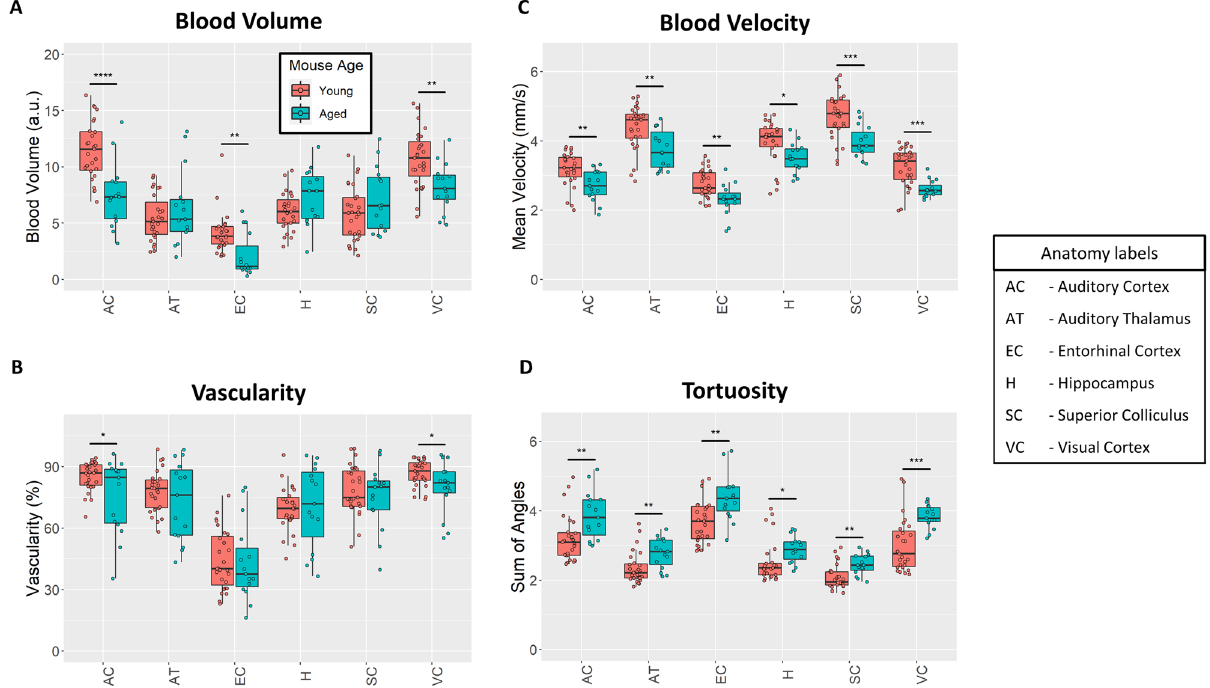
Figure 5. Quantitative ULM measurements. ( A ) Cortical blood volume was significantly decreased in the aged mouse group in comparison to the young group ( p < 0.001 for the auditory cortex, p = 0.007 for entorhinal cortex, and p = 0.001 for visual cortex). ( B ) Likewise, ULM measured vascularity demonstrated a significant decrease in the auditory cortex and visual cortex of the brain between the aged and young group ( p = 0.018 and p = 0.02, respectively). ( C ) Blood velocity exhibited global decreases across all measured brain regions in the aged mouse cohort. The superior colliculus ( p < 0.001) and visual cortex ( p < 0.001) demonstrated the most substantial decrease in mean velocity, with proportionally less decrease in the hippocampus ( p = 0.015), auditory thalamus ( p = 0.003), auditory cortex ( p = 0.004), and entorhinal cortex ( p = 0.001). ( D ) Vascular tortuosity, as measured by sum of angles metric, showed significant increases across all brain regions ( p = 0.004 for auditory cortex, p = 0.006 for auditory thalamus, p = 0.001 for entorhinal cortex, p = 0.041 for hippocampus, p = 0.002 for superior colliculus, and p < 0.001 for the visual